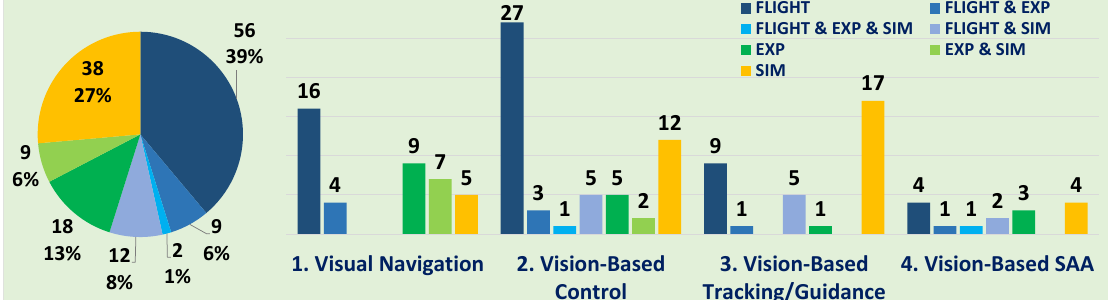
Figure 17. Validation process distribution over the